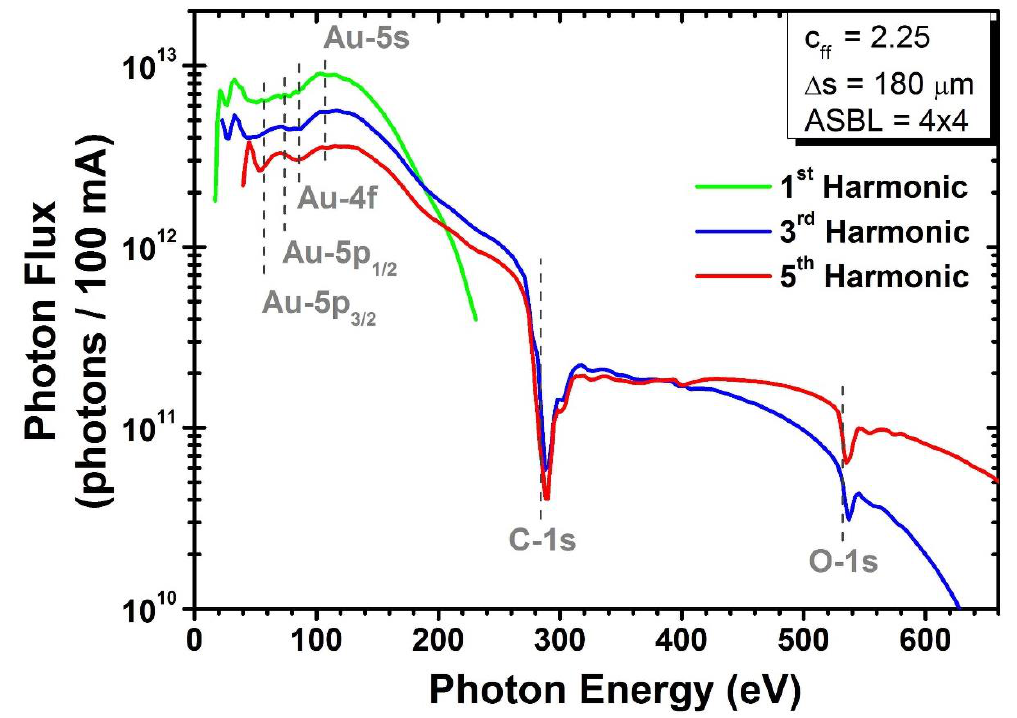
Figure 2: Normalized photon flux (wrt. the synchrotron-ring current) at the exit of the beamline UE112_PGM-1 for standard conditions and three different undulator harmonics. 1 Typically BESSY II runs with a ring current of 300 mA